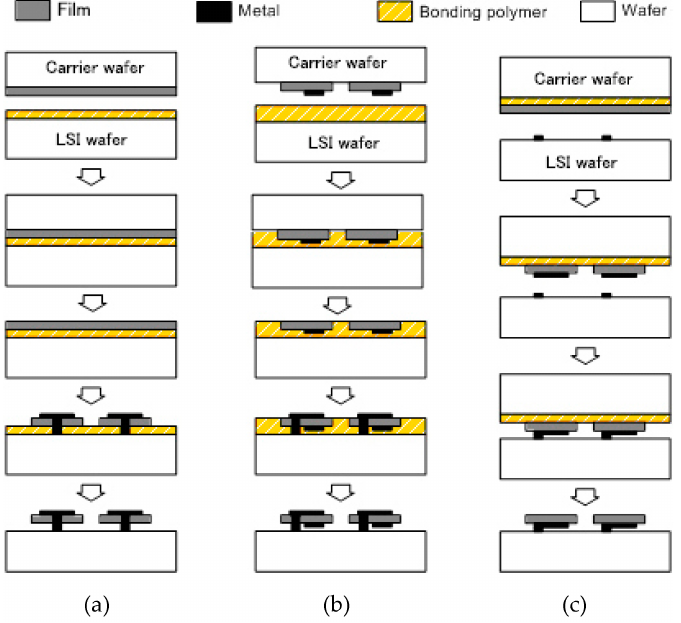
Figure 3. Wafer level transfer of heterogeneous MEMS to LSI; ( a ) film transfer; ( b ) device transfer connectivity last; and ( c ) immediate connectivity at device transfer.